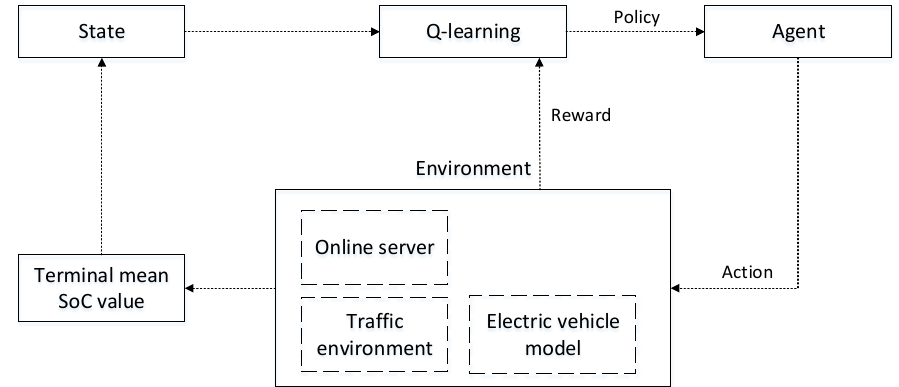
Figure 7. Architecture of proposed reinforcement-learning